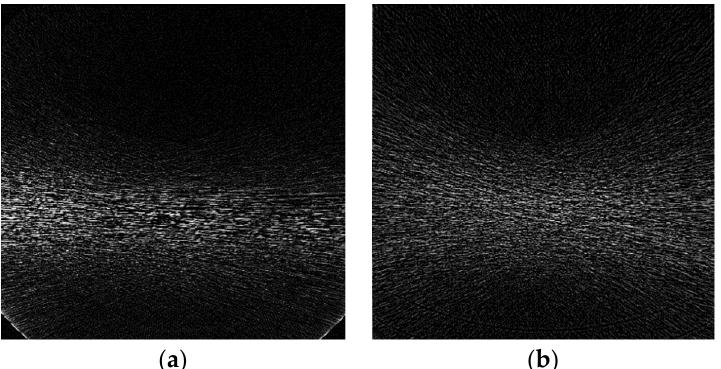
Figure 3. Synthetic noise mask from the sample ( a ) with the Bowtie filter; ( b ) without the Bowtie